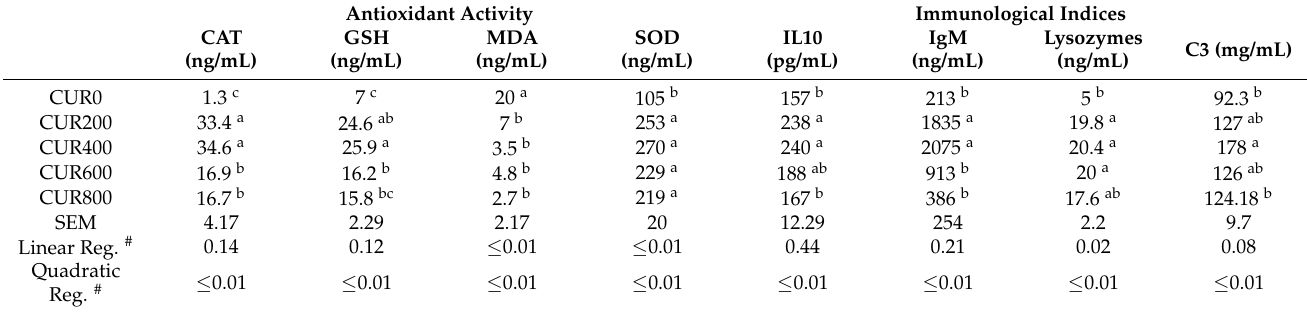
Table 6. The effects of dietary curcumin on the antioxidant and immune status of O. niloticus